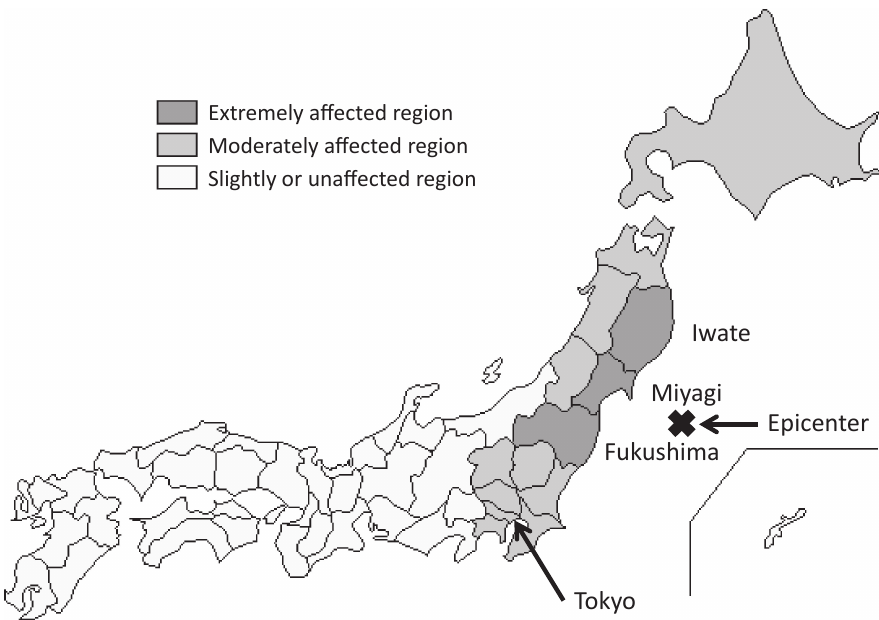
Figure. Categorization of prefectures by the extent of damage caused by the